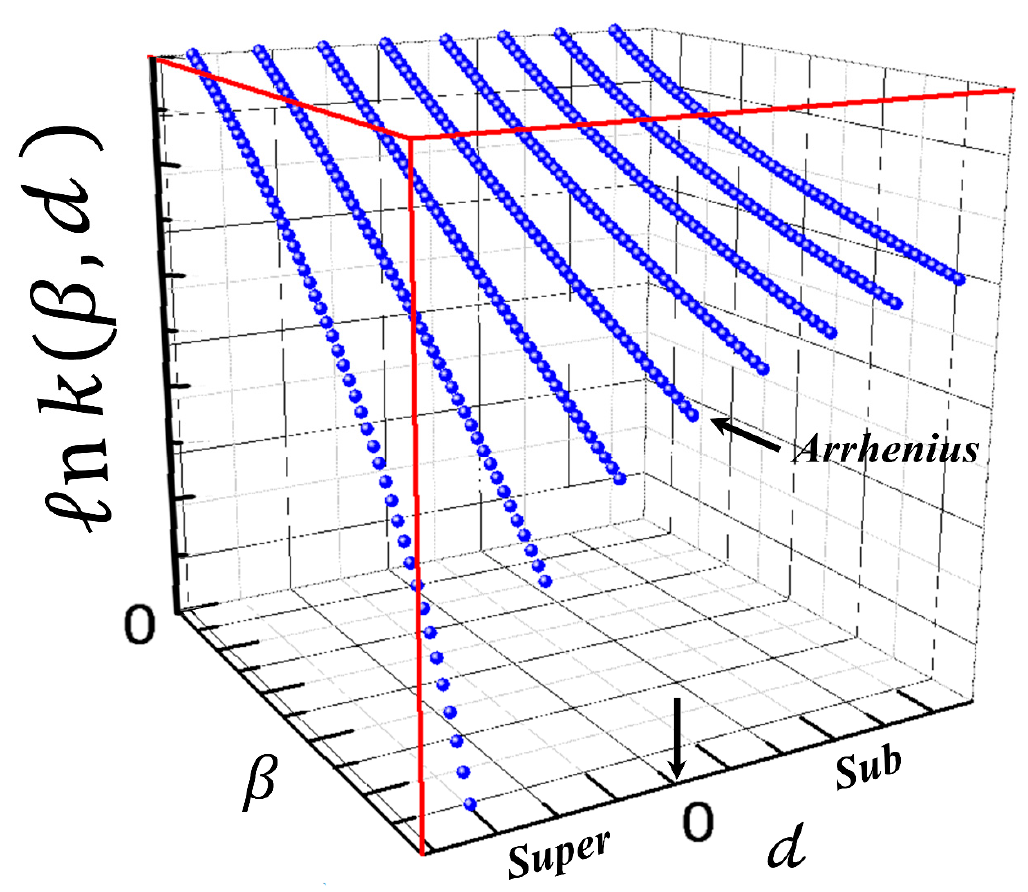
Figure 4. 3D Arrhenius plot illustrating the kinetic limits (Scheme 1) through the functional dependence of the AM rate coefficient k on the parameters d and β . The two kinetic limits apply at the extremes of the range of β . For any value of β , the Arrhenius law is recovered when d tends to zero according to the thermodynamic limit (Scheme 1).